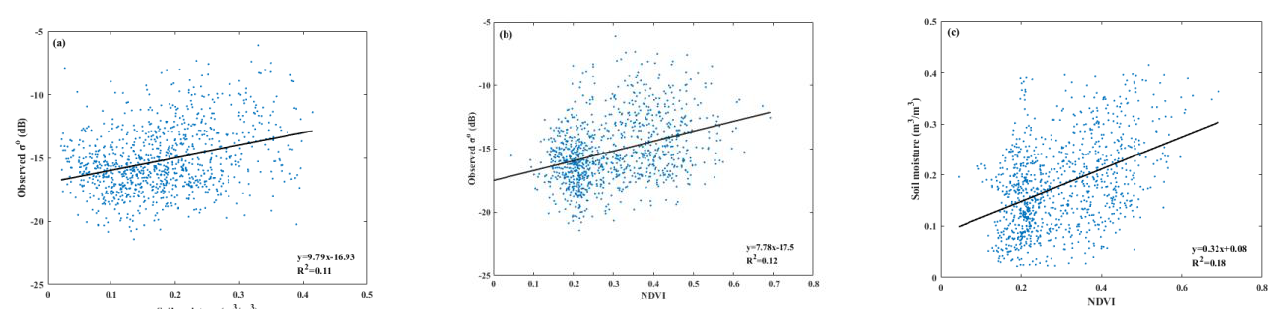
Figure 5. Sensitivity of SAR backscattering coefficients to ( a ) ground measured soil moisture, ( b ) NDVI, and ( c ) relationship between ground measured soil moisture and MODIS NDVI.